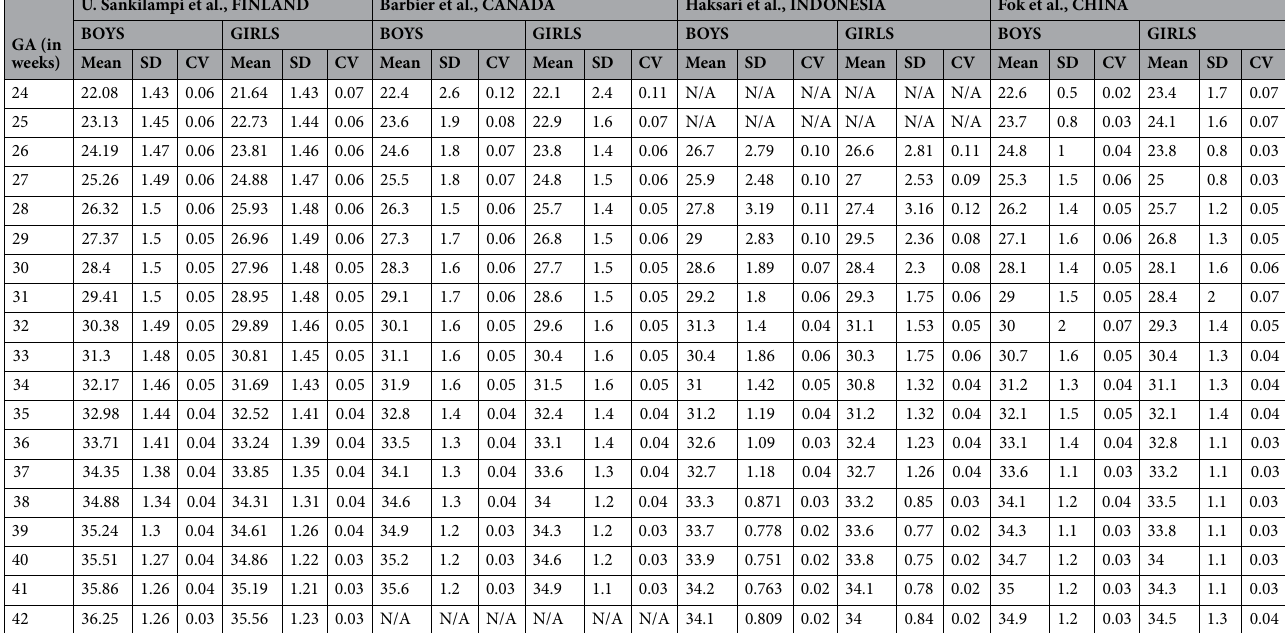
Table 2. The comparison of neonatal head circumference (HC) of Lithuanian newborns by sex and gestational age (GA) and its coefficient of variation (CV) and the data provided by other studies 19,24–28 . SD—standard deviation, CV—coefficient of variation, defined as standard deviation/mean, N/A – not